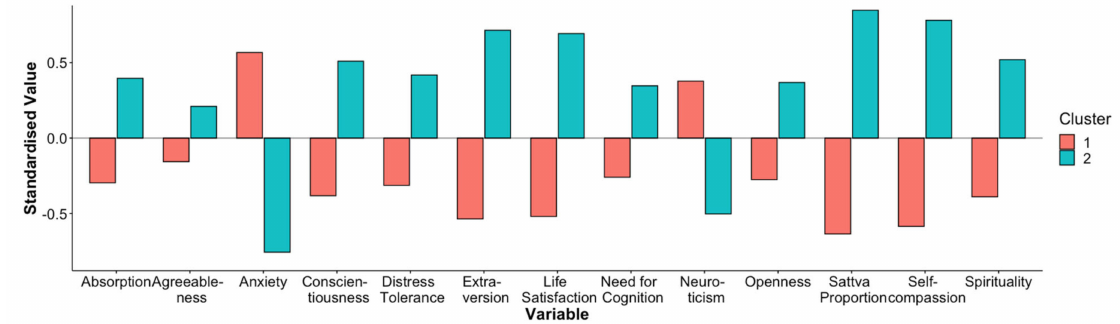
Figure 1. Comparative bar chart displaying the mean of various personality traits for both clusters.